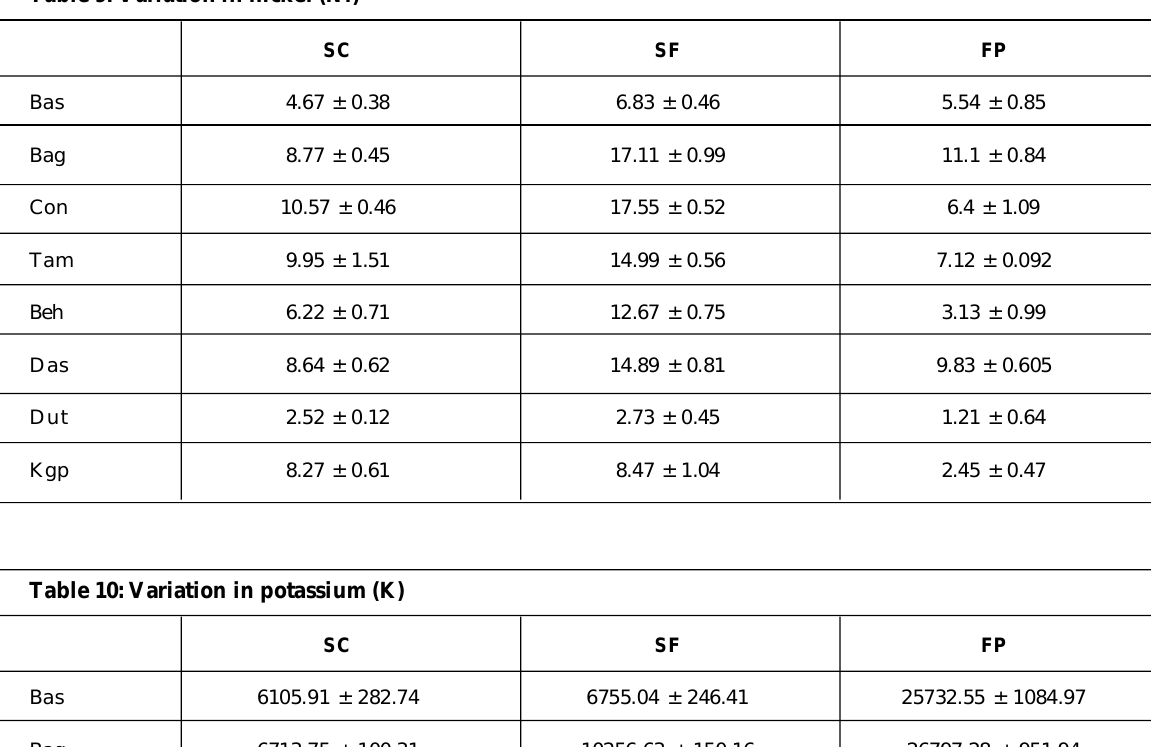
Table 9: Variation in nickel